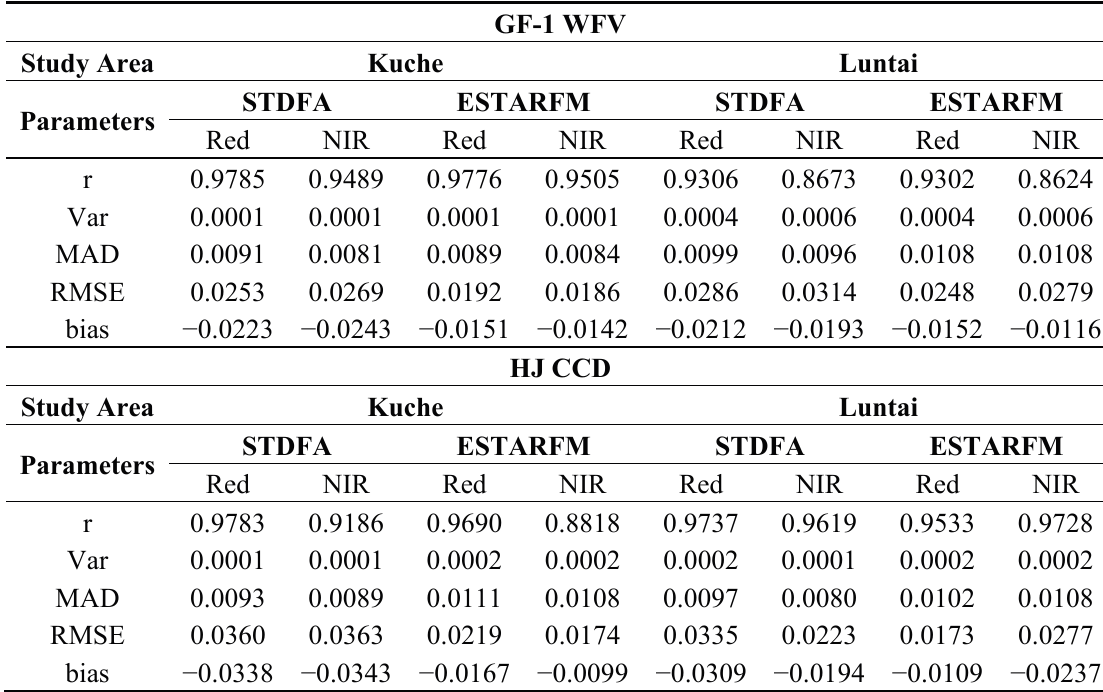
Table 6. Results of the correlation analysis between synthetic data generated using MOD09GA data and actual data.